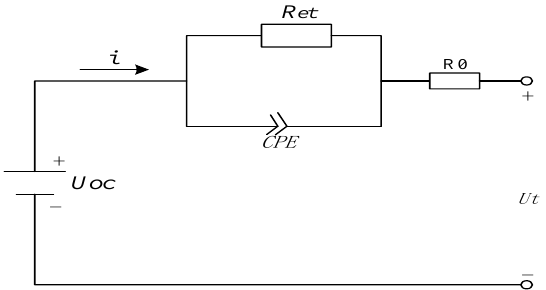
Figure 2. A commonly used fractional model.